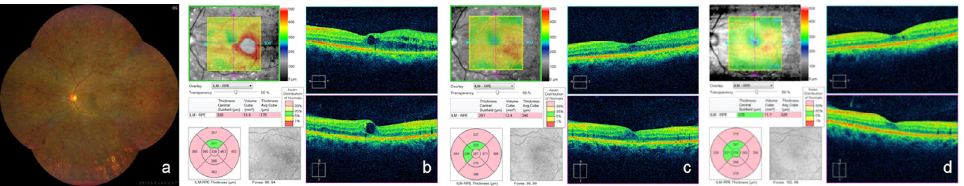
Figure 3. A treatment-naïve case (case 20) with good response to intravitreal faricimab injection. ( a ) a montage color fundus photograph at baseline; ( b – d ) optical coherence tomography images. Macular edema observed at baseline ( b ) disappeared 1 month after the intravitreal faricimab injection ( c ). No recurrence of macular edema was noted for up to 4 months without additional treatment.